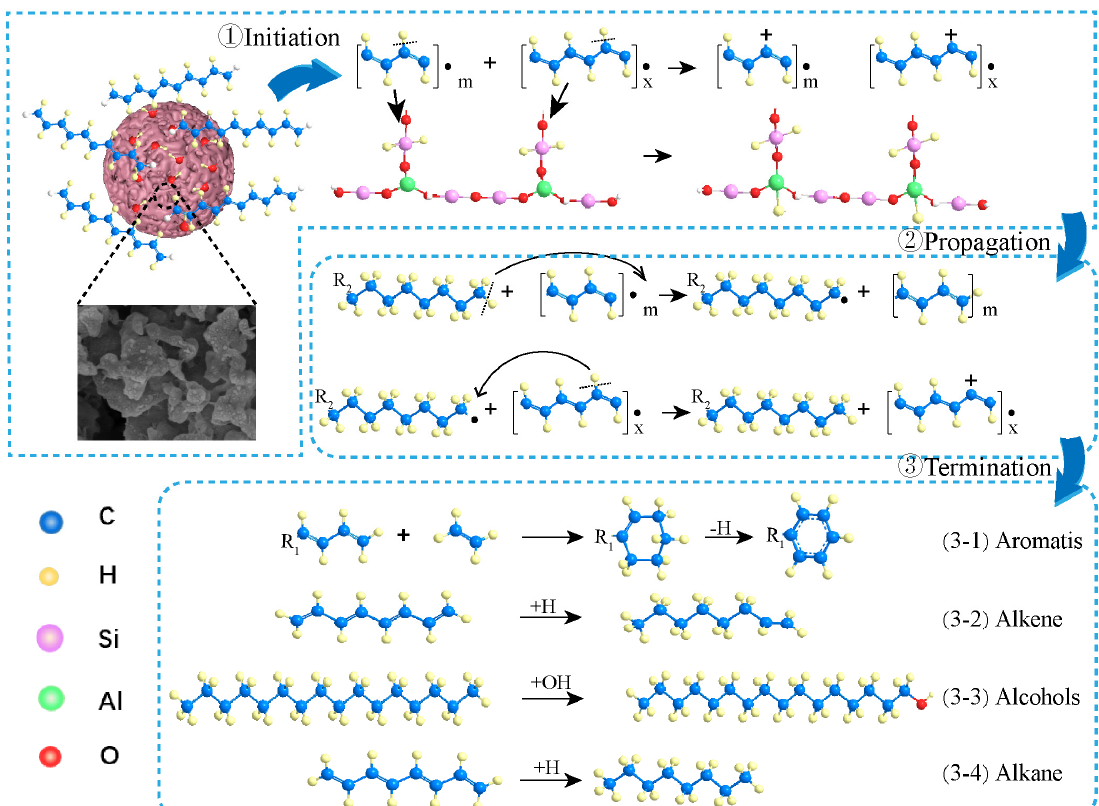
Figure 8. Image of the NMGM thermal catalytic-cracking LDPE